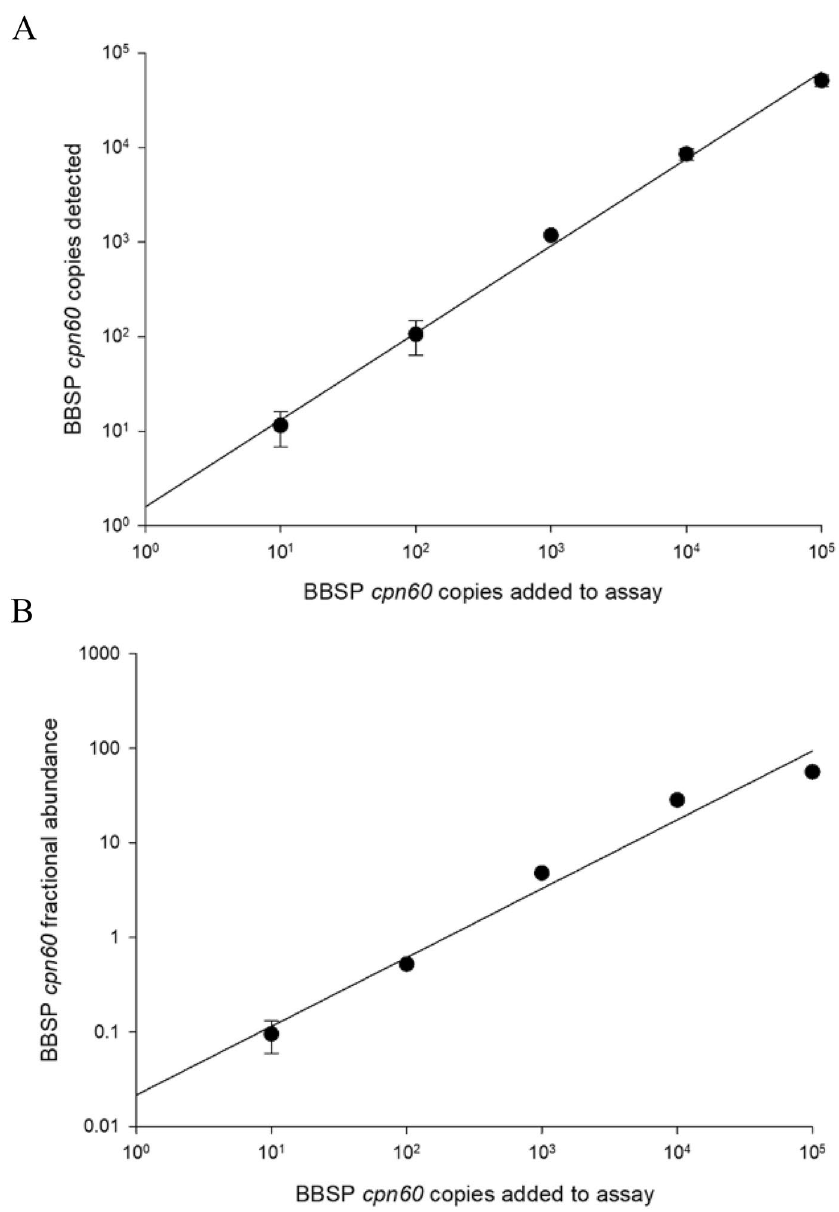
Figure 1. Quantification of BBSP cpn60 in healthy blueberry tissues spiked with known copy numbers of BBSP cpn60 plasmids. ( A ) Relationship between copies added and copies detected by ddPCR. ( B ) Fractional abundance (FA) of spiked BBSP cpn60 in relation to blueberry DNA, as determined using the blueberry rubisco internal control